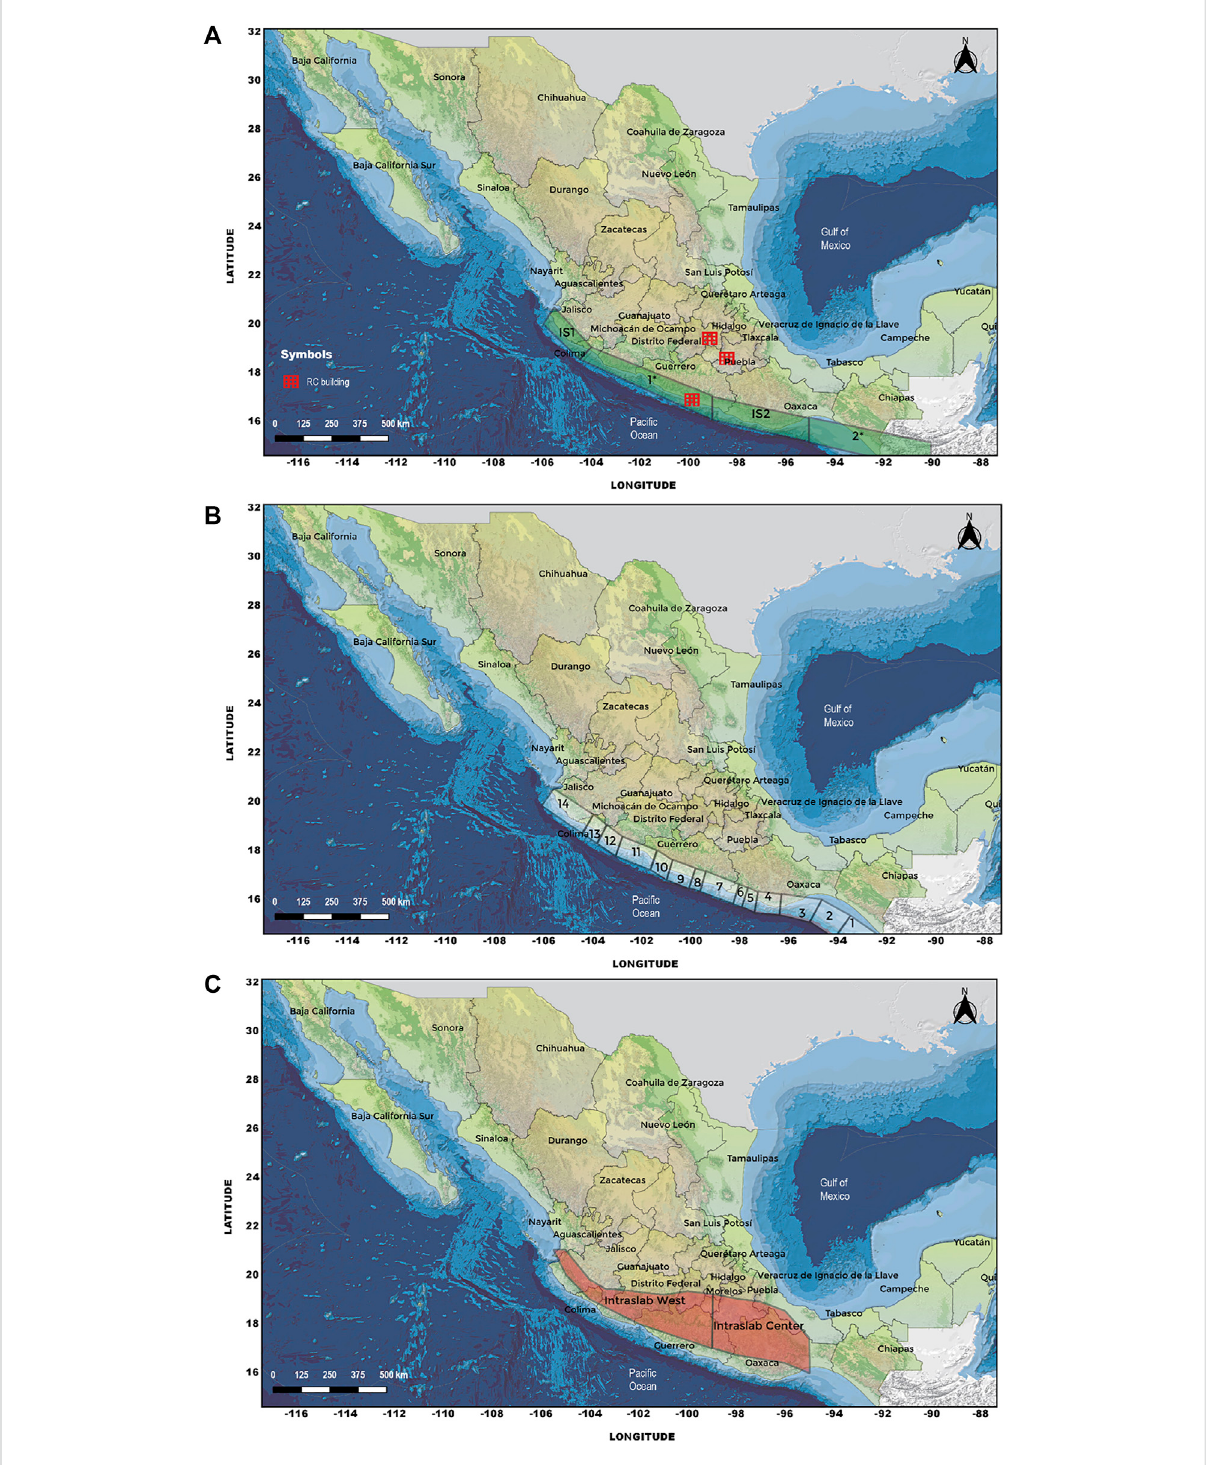
FIGURE 3 Seismicsourcezones: (A) interplatewith4.5 < M w < 7.0andlocationsofthestudiedbuildings; (B) interplatewithM w ≥ 7.0; (C) intraslabwith4.5 < M w <